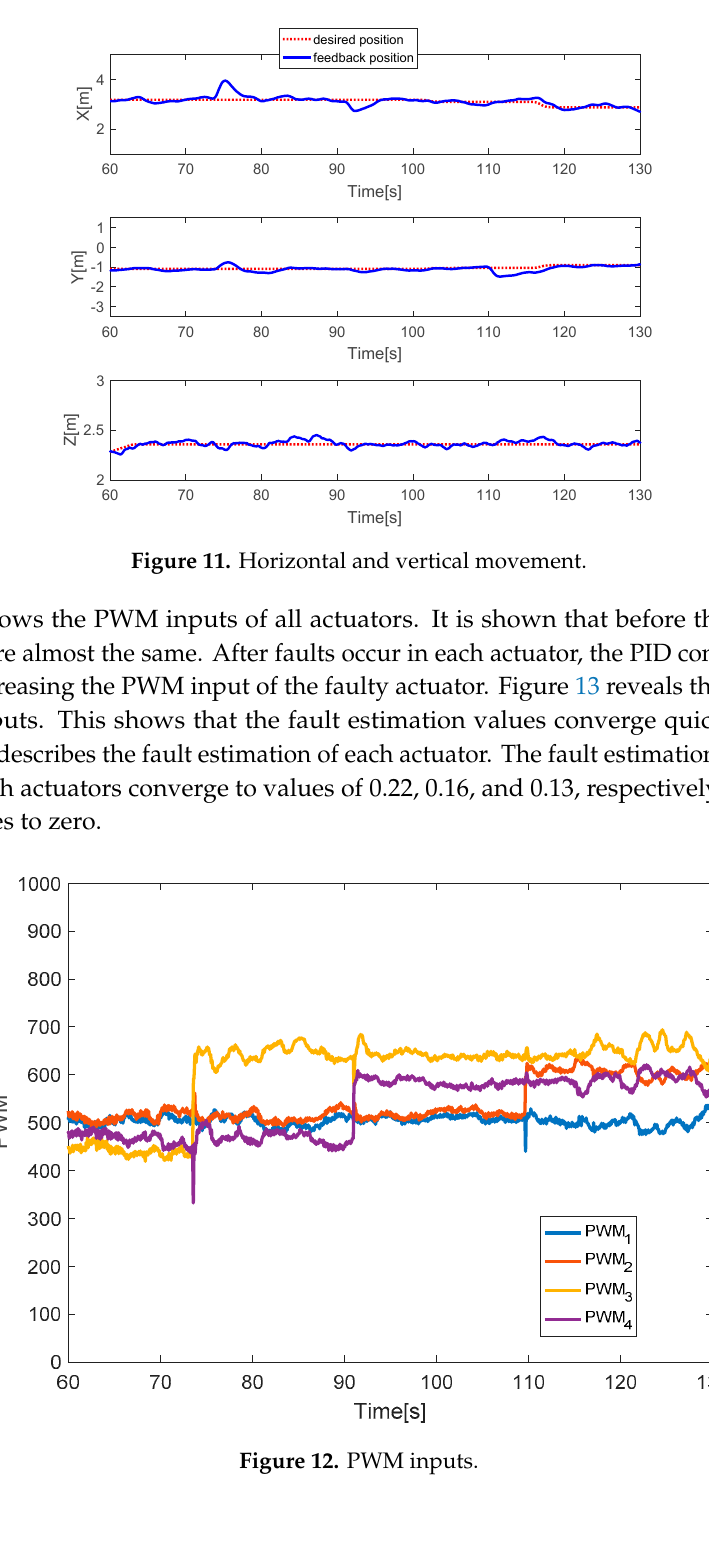
Figure 11. Horizontal and vertical movement.